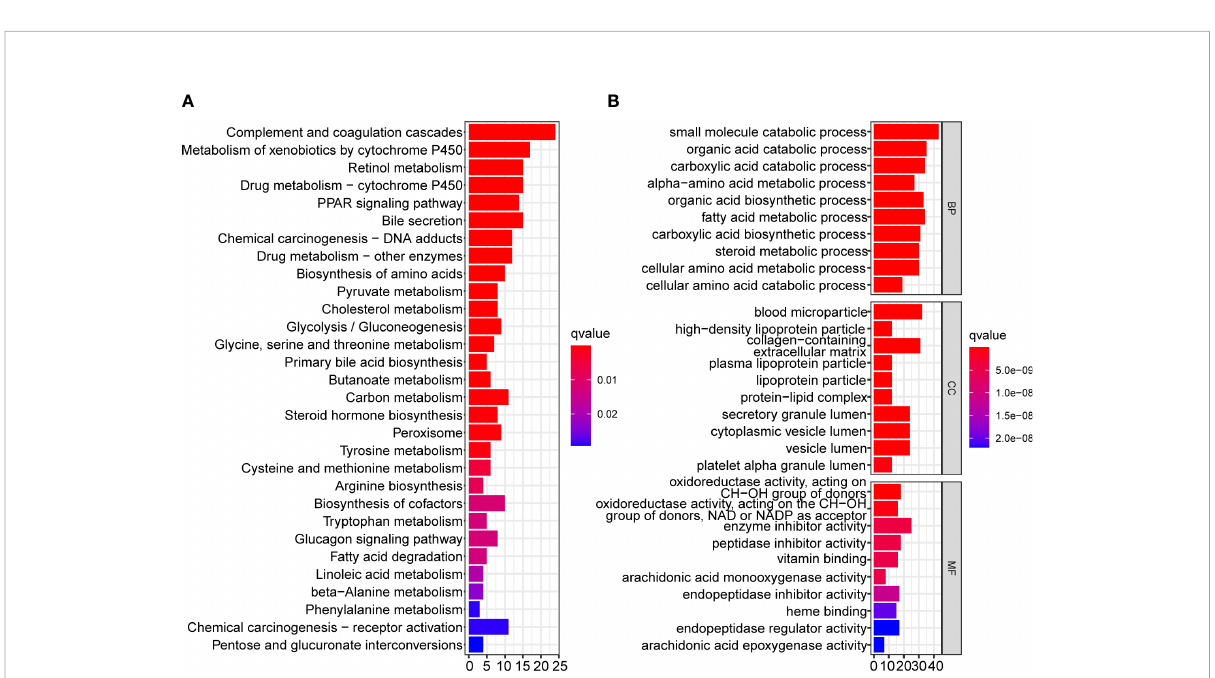
FIGURE 6 Functional enrichment analysis of DEGs between two mitophagy-related subtypes. Bar plots showing the biological function of DEGs using KEGG (A) and GO (B) enrichment. DEGs, Differentially expressed genes; KEGG, Kyoto encyclopedia of genes and genomes; GO, Gene